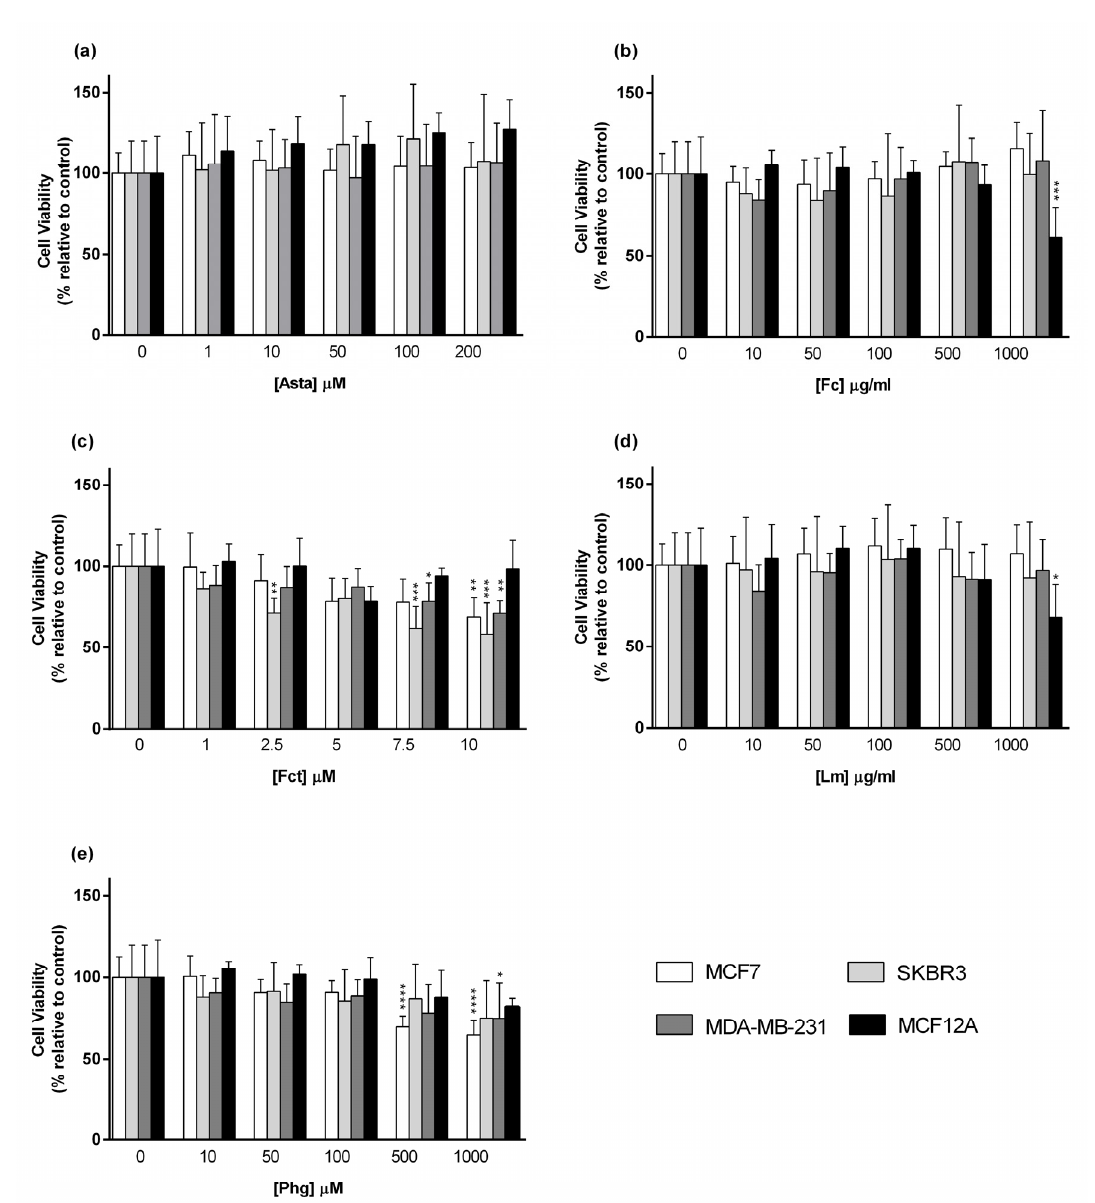
Figure 2. Cytotoxic effect of ( a ) Astaxanthin (Asta), ( b ) Fucoidan (Fc), ( c ) Fucosterol (Fct), ( d ) Laminarin (Lm), and ( e ) Phloroglucinol (Phg) assessed by MTT assay after 72 h of exposure in the panel of breast cell lines cultured in monolayer. Control corresponds to cells with medium containing 0.1% DMSO. The percentages of cell viability are relative to the controls and presented as mean + standard deviation of six independent experiments (each in triplicate). (* p < 0.05, ** p < 0.01, *** p < 0.001, **** p < 0.0001).